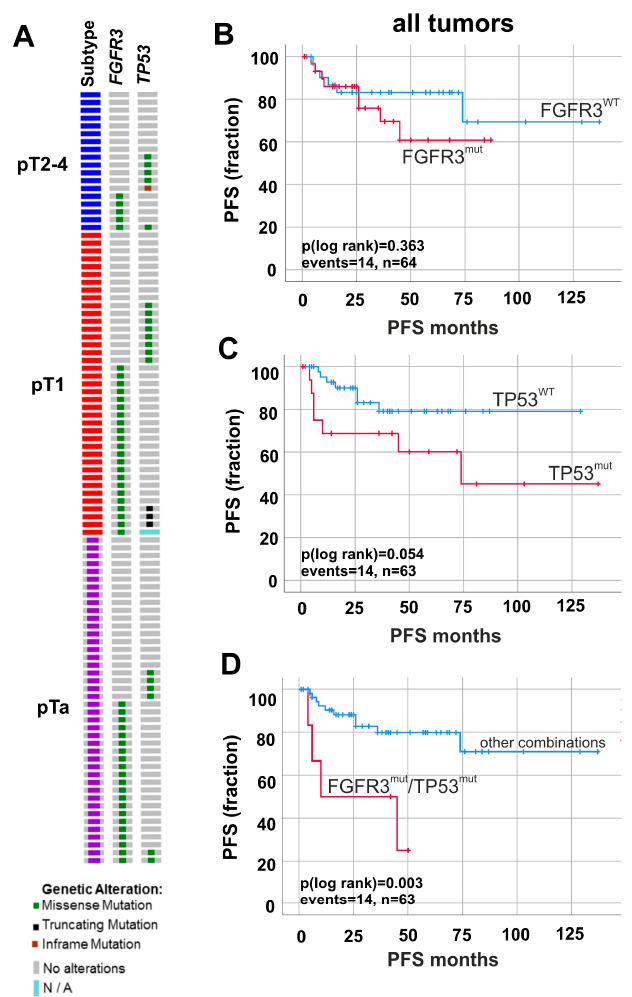
Figure 4. FGFR3 and TP53 mutation frequency and prognostic impact on tumor progression. ( A ) Oncoprint graph for FGFR3 and TP53 mutation analysis. ( B – D ) Kaplan–Meier survival curves display progression-free survival (PFS). ( B ) Survival curves of tumors with detected FGFR3 mutations (red curve, n = 30) compared to non-mutated FGFR3 gene status (blue curve, n = 34). ( C ) Kaplan–Meier analysis of tumors with mutated TP53 (red curve, n = 17) compared to wildtype TP53 (blue curve, n = 46). ( D ) Impact of double mutations on risk stratification of tumor progression is demonstrated. Univariate analysis of double mutations (red curve, n = 6) compared to all other combinations of mutated and non-mutated FGFR3 and TP53 genes (blue curve, n = 57). n , overall number of cases; events, overall events of tumor progression. Table 4. Multivariate Cox regression analysis of molecular markers including all factors potentially influencing